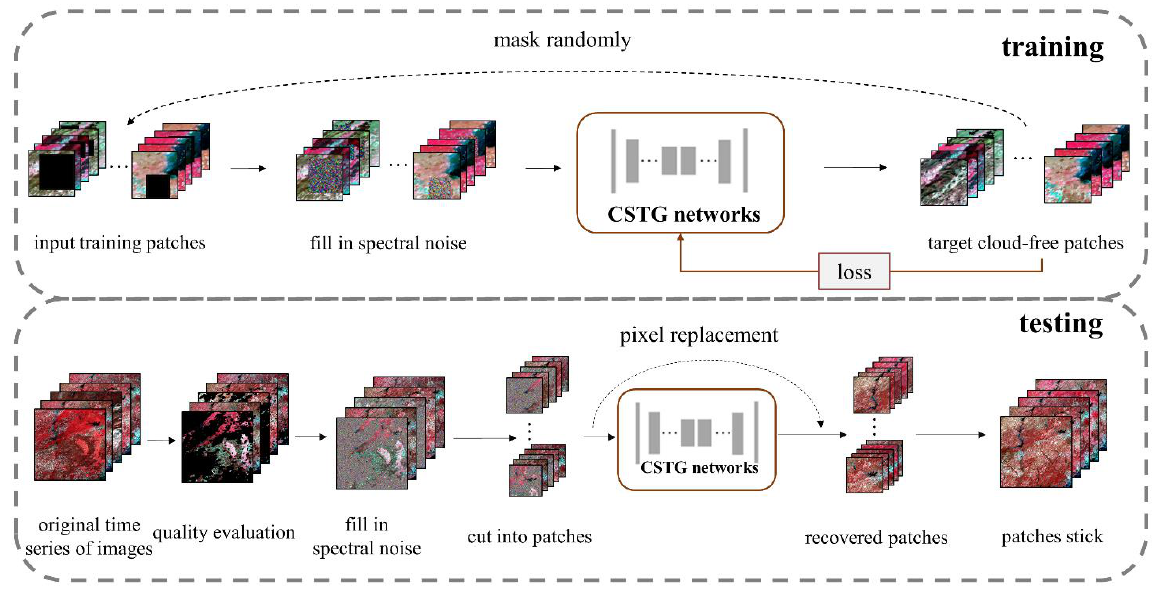
Figure 2. The flowchart of the proposed recovery method. The first line shows the model training process, and the second line shows the model testing process.